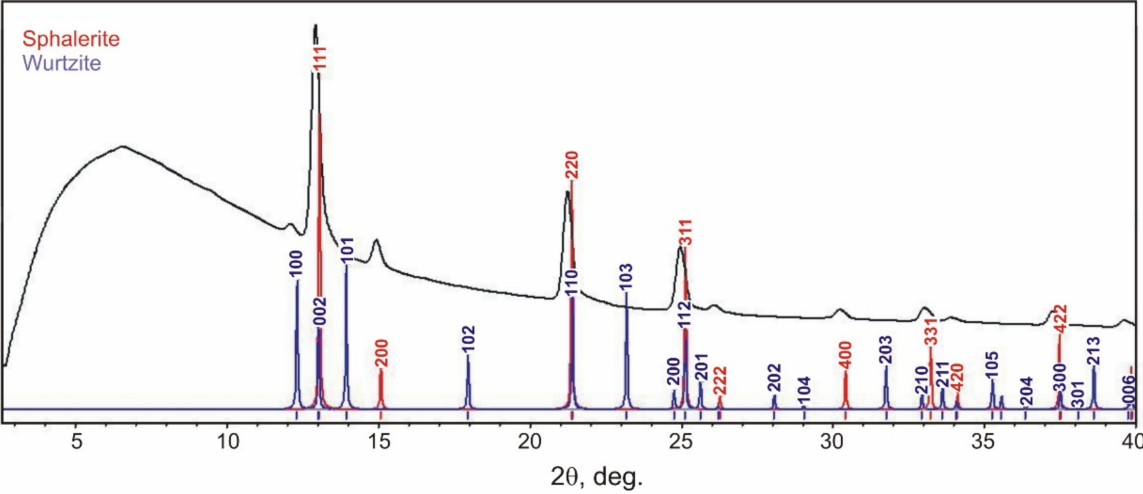
Figure 17. The powder diffraction pattern generated from the frames of a single crystal diffraction experiment of Mongolian high-Hg sphalerite in comparison with calculated powder diffraction patterns of sphalerite (red line) and wurtzite (blue